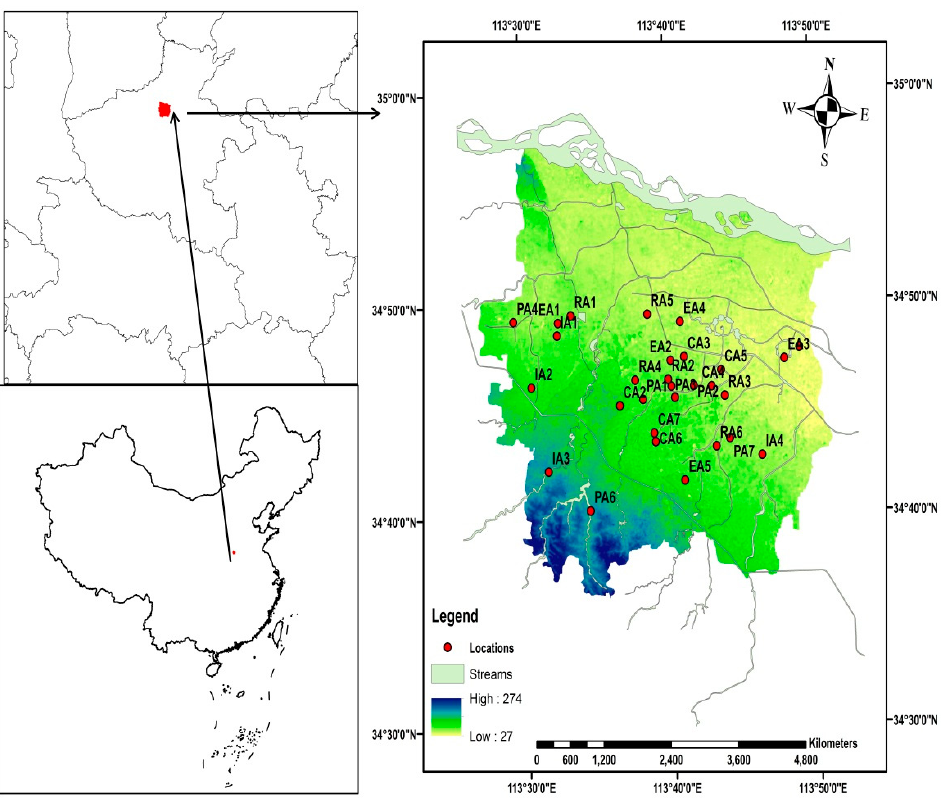
Figure 1. Research area